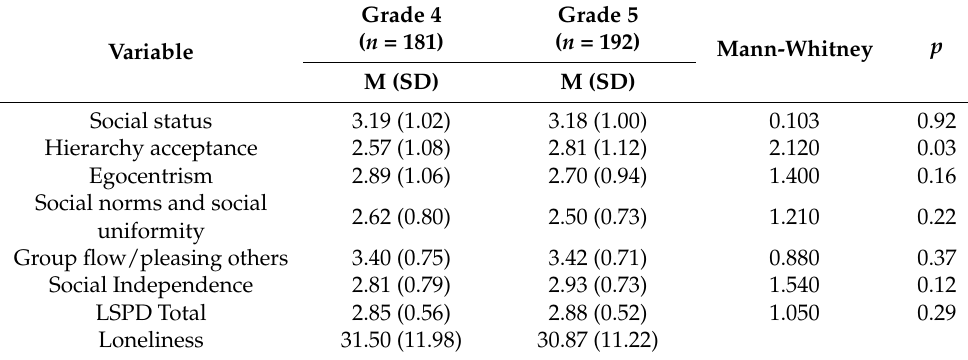
Table 5. Comparison between Grade 4 and Grade 5 in study